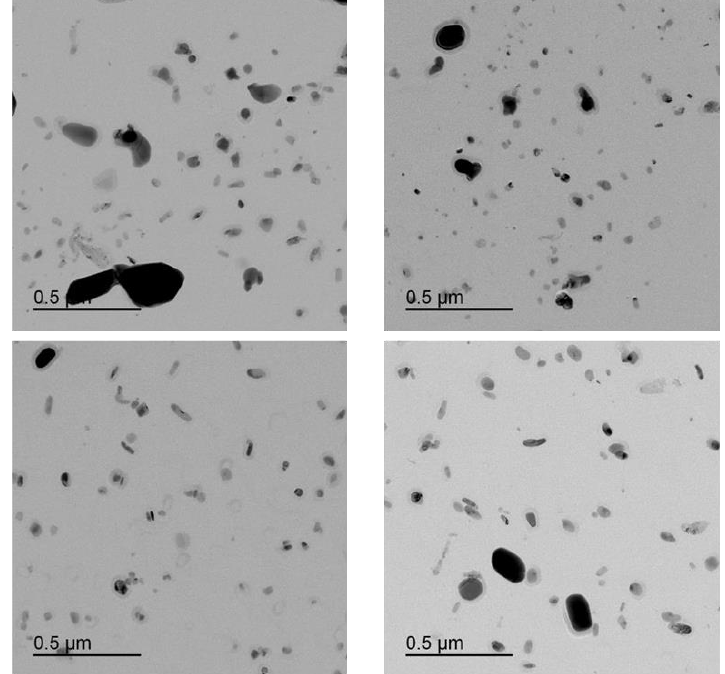
Figure A10. Failed crept cross-weld specimen 91-HAZ-3-6 600 °C 99 MPa 4280 h. TEM images on a carbon extraction replica at 100,000X.